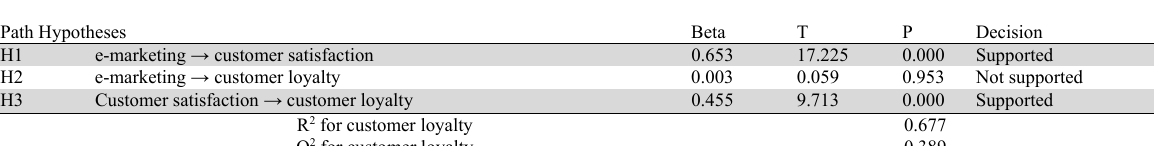
Hypotheses Analyses Path